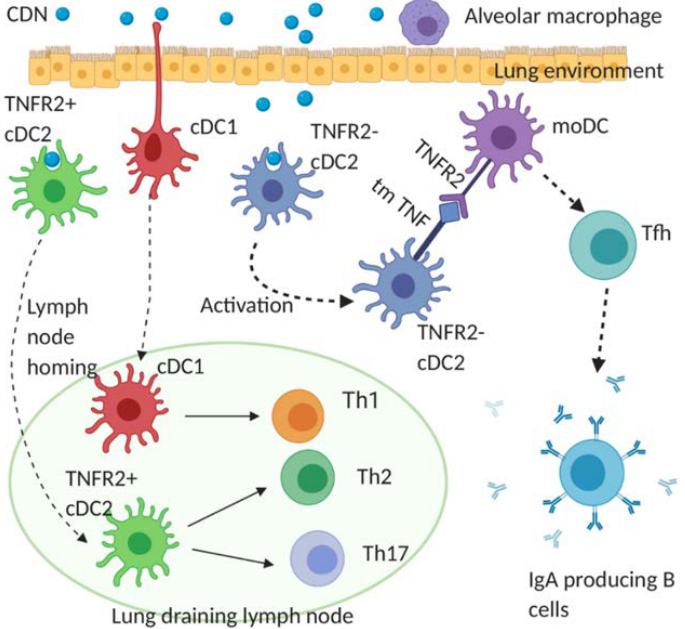
Figure 2. Cellular mechanism of CDN adjuvanticity by lung DCs. Intranasal immunization of CDN promotes its uptake by functionally distinct lung DC subsets: cDC1, TNFR2 + cDC2, and TNFR2 - cDC2. Upon the CDN uptake, cDC1 and TNFR2 + cDC2 mature and migrate towards the lung draining lymph node where they direct naïve T cells towards Th1, Th2, and Th17 e ff ector cells. The TNFR2 - cDC2 population, on the CDN uptake, is activated but does not migrate. Instead, the TNFR2 - cDC2 produces transmembrane TNF, which engages TNFR2 on monocyte-derived DCs (moDCs) to trigger lung moDCs activation. Activated lung moDCs induce Tfh, GC formation, and IgA production in the